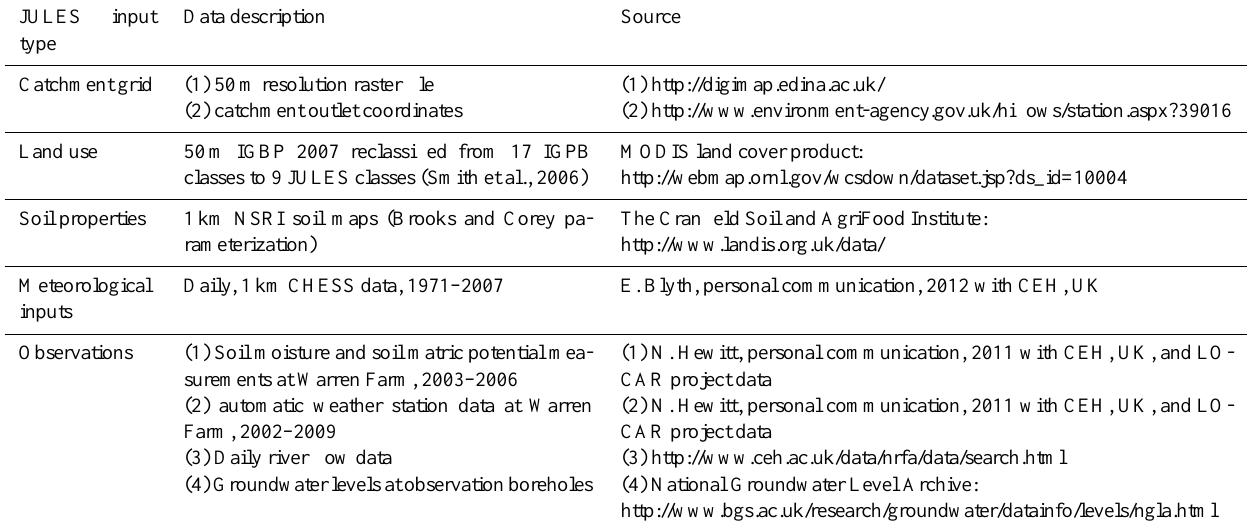
Table 1. Data used for JULES set-up and performance evaluation.